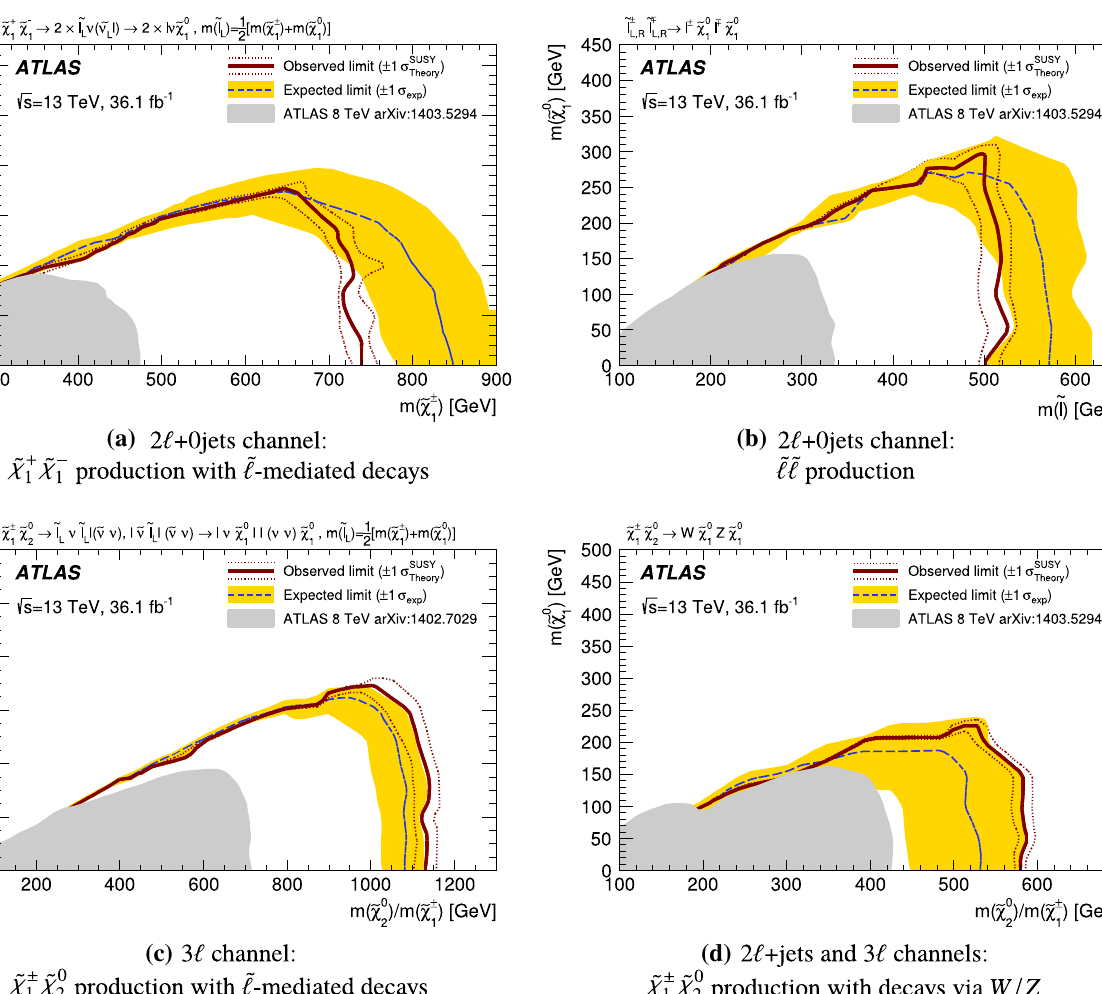
Fig. 8 Observed and expected exclusion limits on SUSY simplified models for a chargino-pair production, b slepton-pair production, c chargino–neutralino production with slepton-mediated decays, and d chargino–neutralino production with decays via W / Z bosons. The observed (solid thick red line) and expected (thin dashed blue line) exclusion contours are indicated. The shaded band corresponds to the